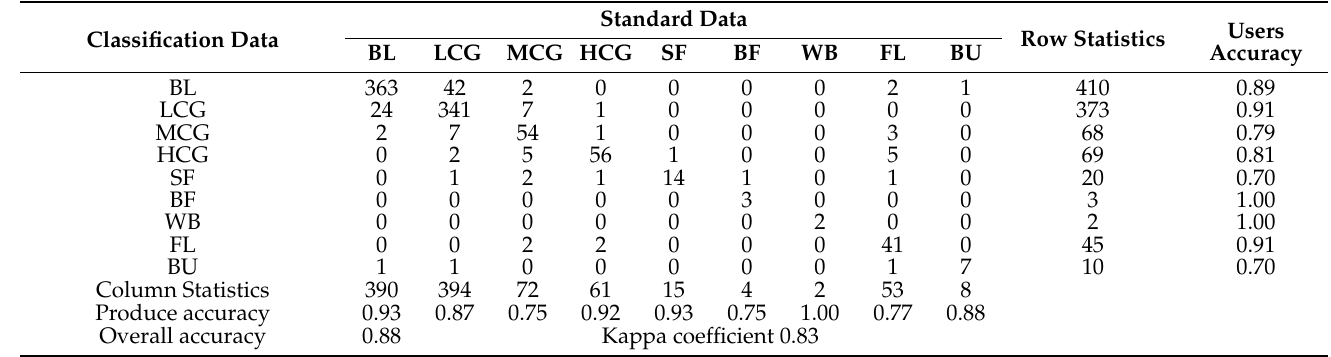
Table A1. Confusion matrix of land use mapping in Dunhuang oasis in 1990.